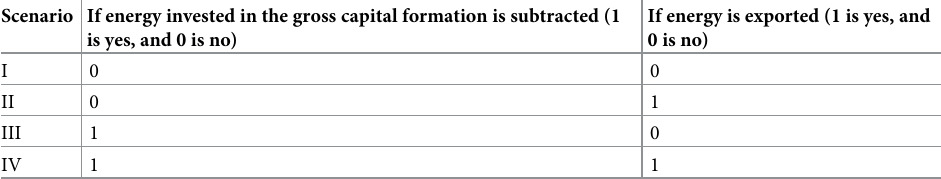
Table 2. Scenario design and description.